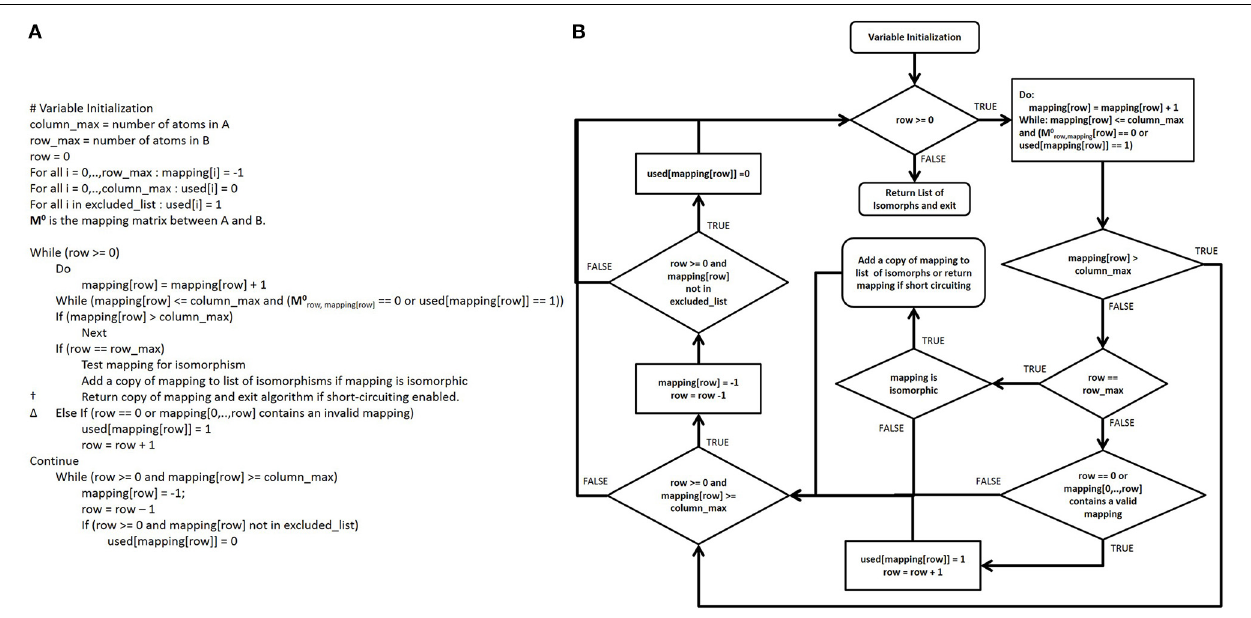
FIGURE 6 | Pseudocode and control flow diagram of the CASS algorithm. (A) Pseudocode for CASS. In this algorithm, matrices are neither copied nor modified, saving considerable computational time and memory. Also, the control flow is cleaner than in the modernized Ullmann algorithm pseudocode. Additionally, our short-circuiting method in the line marked † allows the algorithm to terminate early when a valid mapping has been